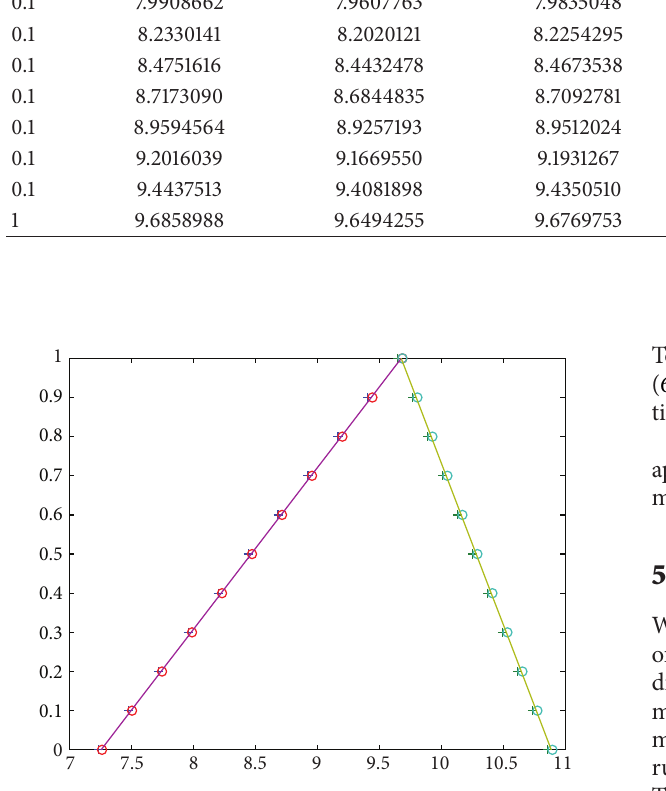
Figure 3: (-) Exact solution, ( ∘ ) Trapezoidal, and (+) Midpoint approximated